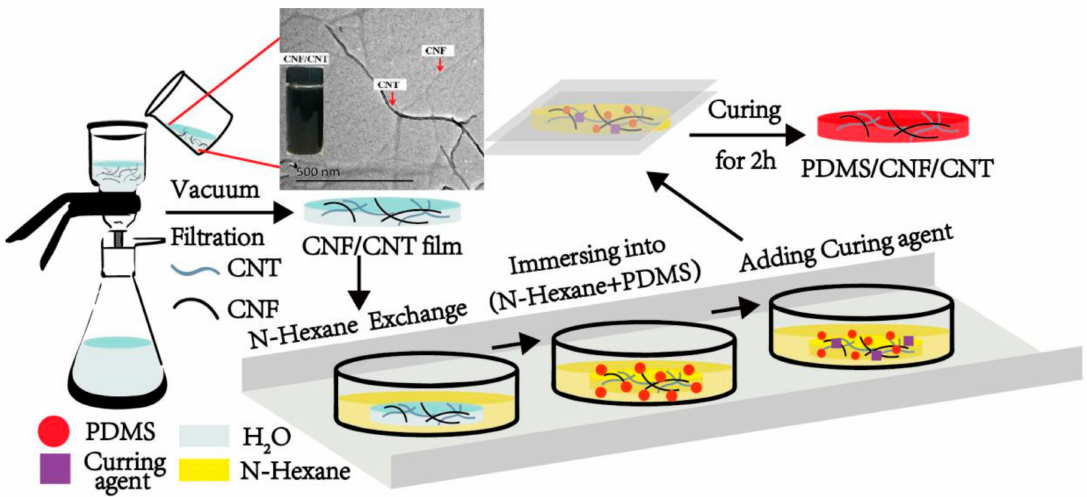
Figure 1. Preparation route of Polydimethylsiloxane/cellulose nanofiber/carbon nanotube (PDMS/CNF/CNT) nanocomposite and the TEM image of CNF/CNT mixture suspension (the inserted digital image of CNF/CNT dispersion exhibited uniform appearance even after two